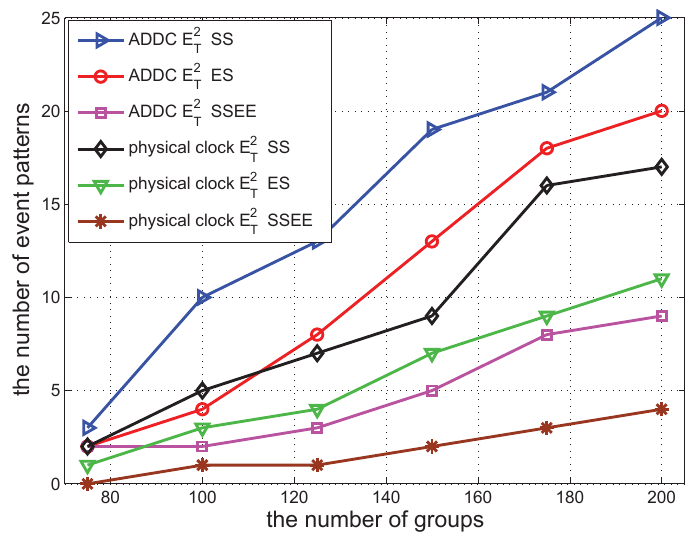
Figure 10. The number of event patterns vs. the number of groups.